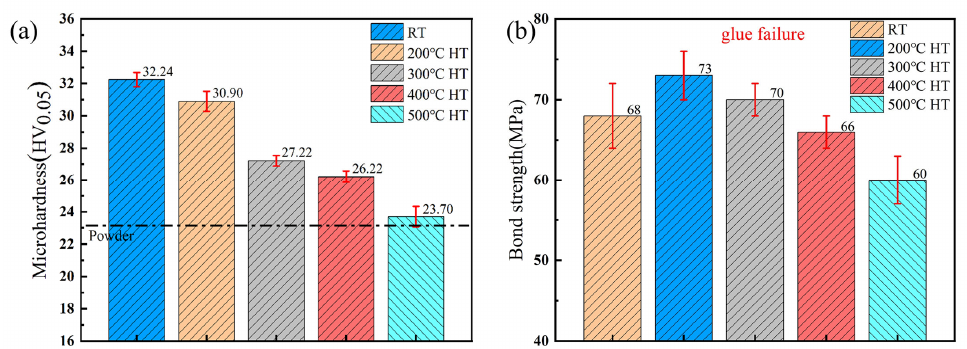
Figure 8. Mechanical properties of Al coatings after heat treatment: ( a ) microhardness and ( b ) bond- ing strength.